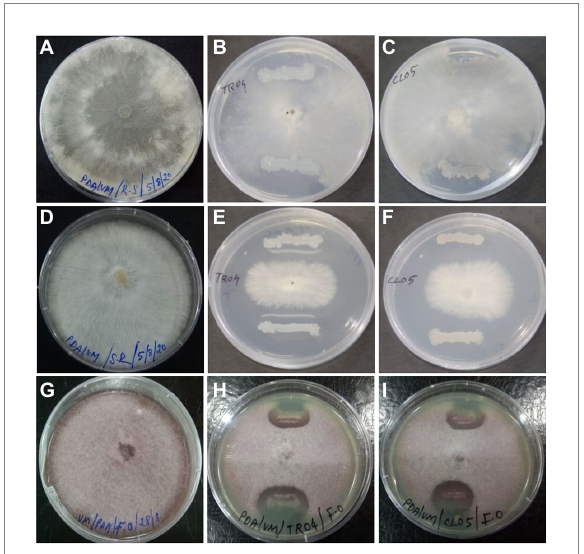
FIGURE 1 Antagonistic property of endophytic Bacillus subtilis strains TRO4 and CLO5 against soil-borne fungal pathogens. (A) R. solani control, (B) R. solani vs. TRO4, (C) R. solani vs. CLO5, (D) S. rolfsii control, (E) S. rolfsii vs. TRO4, (F) S. rolfsii vs. CLO5, (G) F. oxysporum control, (H) F. oxysporum vs. TRO4, (I) F. oxysporum vs.